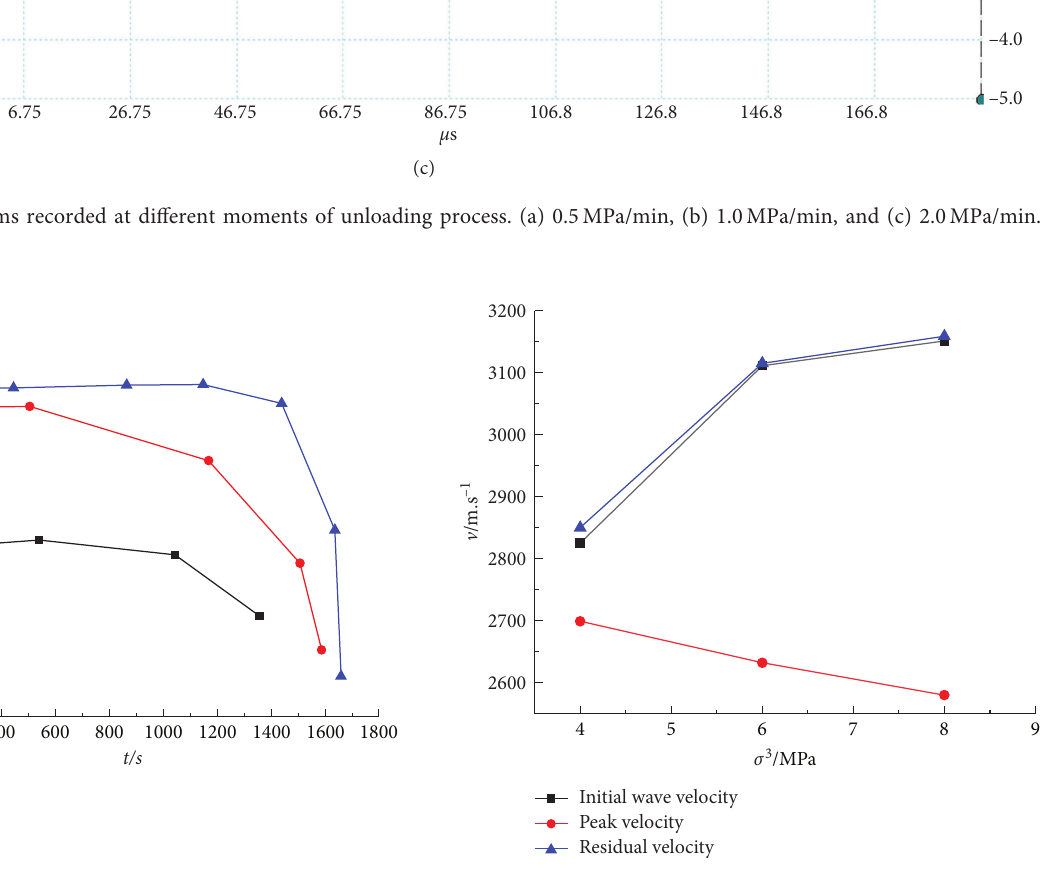
Figure 13: Relation curves of AW velocity and initial confining